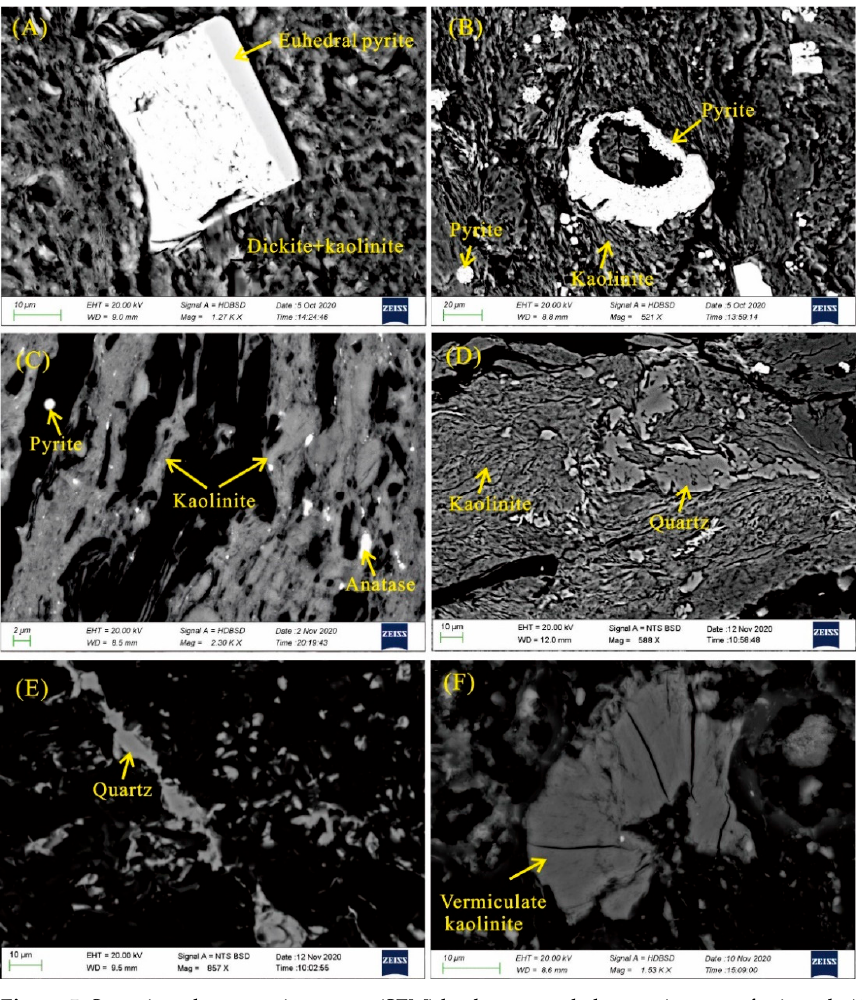
Figure 5. Scanning electron microscope (SEM) back-scattered electron images of minerals ( A – F ). ( A ) Euhedral pyrite embedded within dickite matrix (sample SL-9); ( B ) massive pyrite, framboidal pyrite, and kaolinite matrix (sample SL-9); ( C ) kaolinite layers and lenses, combined with fine-grained disseminated anatase particles (sample SL-16); ( D ) kaolinite matrix and quartz-filled cavities (sample SL-13); ( E ) fracture-filled quartz (sample SL-16); ( F ) vermiculate kaolinite (sample